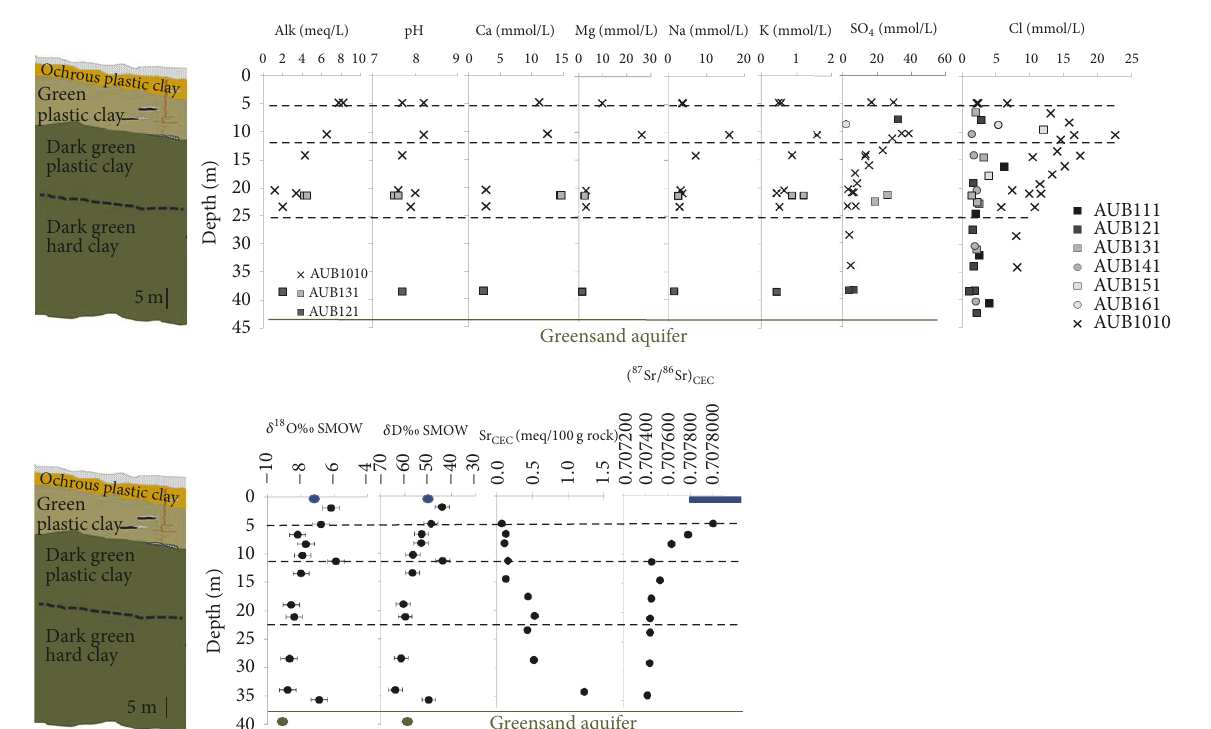
Figure 11: Chemical characterization of pore waters and weathering profile. (a) Chloride and sulfate concentrations of pore waters as a function of depth based on anion leaching data and directly measured on pore waters extracted by squeezing (all boreholes). (b) Profiles of alkalinity, pH cation (squeezing), and anion concentrations (squeezing and leaching data) in pore waters as a function of depth. (c) Profiles of 𝛿 18 O and 𝛿 D of pore waters, contents, and 87 Sr/ 86 Sr of exchangeable strontium through the T´egulines Clay (AUB1010 borehole only). Blue points and lines correspond to meteoric waters and green points to Greensand